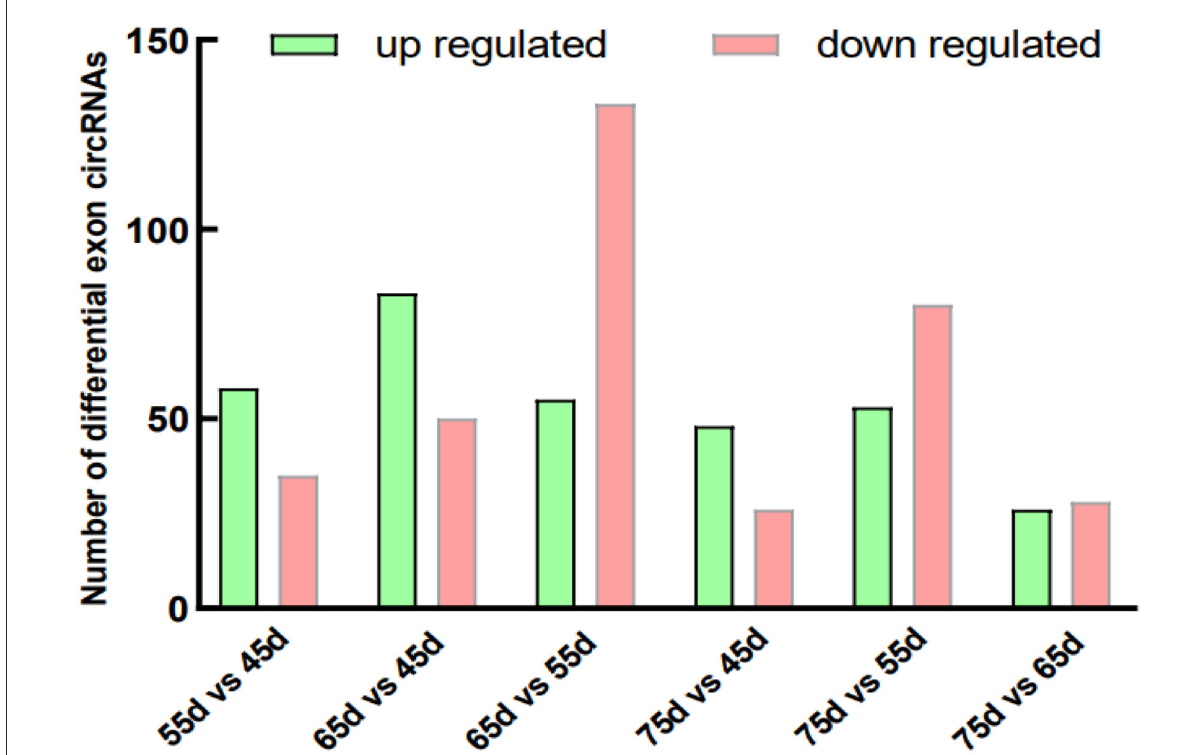
FIGURE1 Differentially exon circRNAs in different groups. The green column represents upregulated circRNA and the pink column represents downregulated.